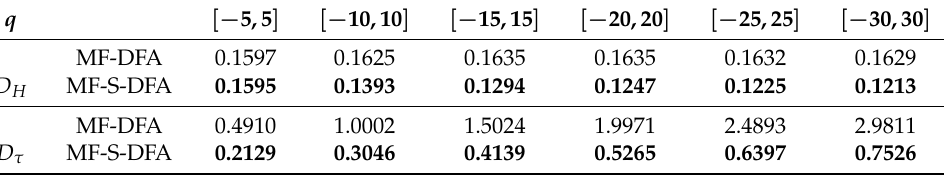
Table 2. D H and D τ for two methods with different domains of q .